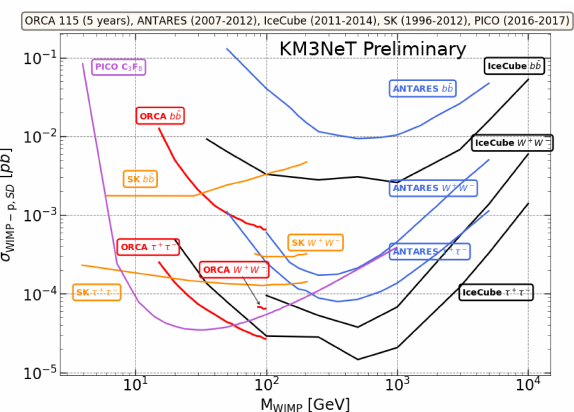
Figure 7. Limits on the WIMP-proton spin-dependent scattering cross sections as a function of the WIMP mass for ANTARES (5 years [48]) and ORCA (5 years of simulated data [49]). Limits from Ice Cube [98], Super Kamiokande [105] and PICO [106] are also shown for comparison. Credit: ANTARES and KM3NeT